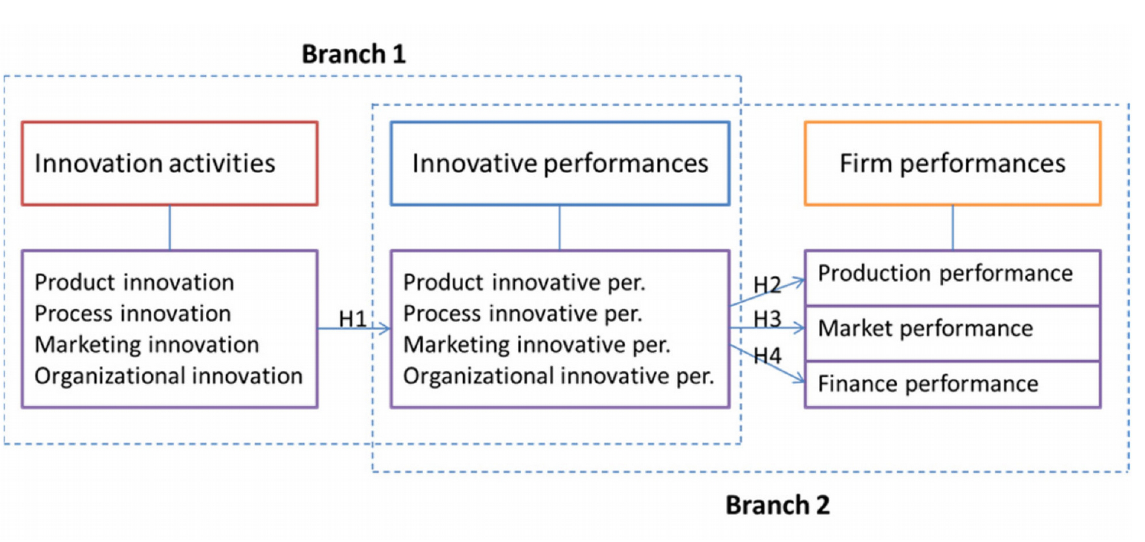
Figure 2. Hypothesis development of the effects of innovation on firm performance